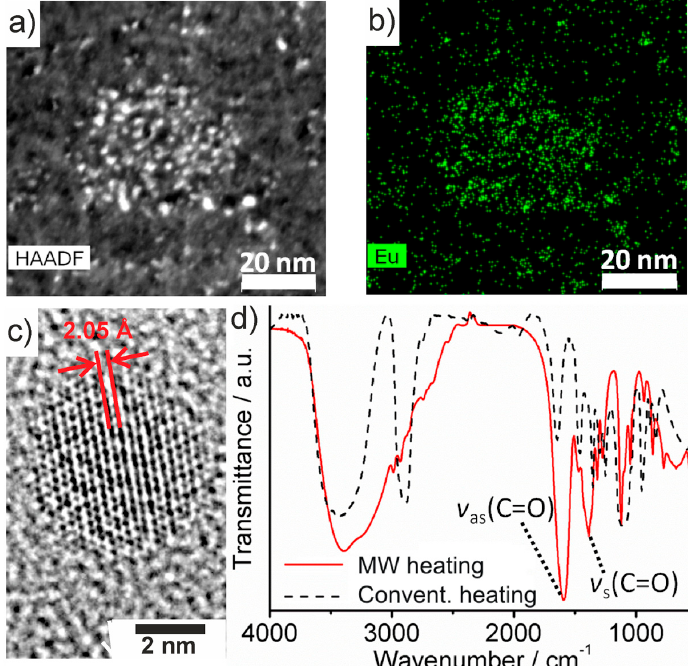
Figure 6. Composition and surface functionalization of MW-heated Eu 3+ -modified C-dots: ( a ) HAADF-STEM image; ( b ) Eu elemental mapping; ( c ) HRTEM image with lattice distance; and ( d ) FT- IR spectra of MW-heated C-dots ( red ) in comparison to conventionally heated C-dots ( black ).